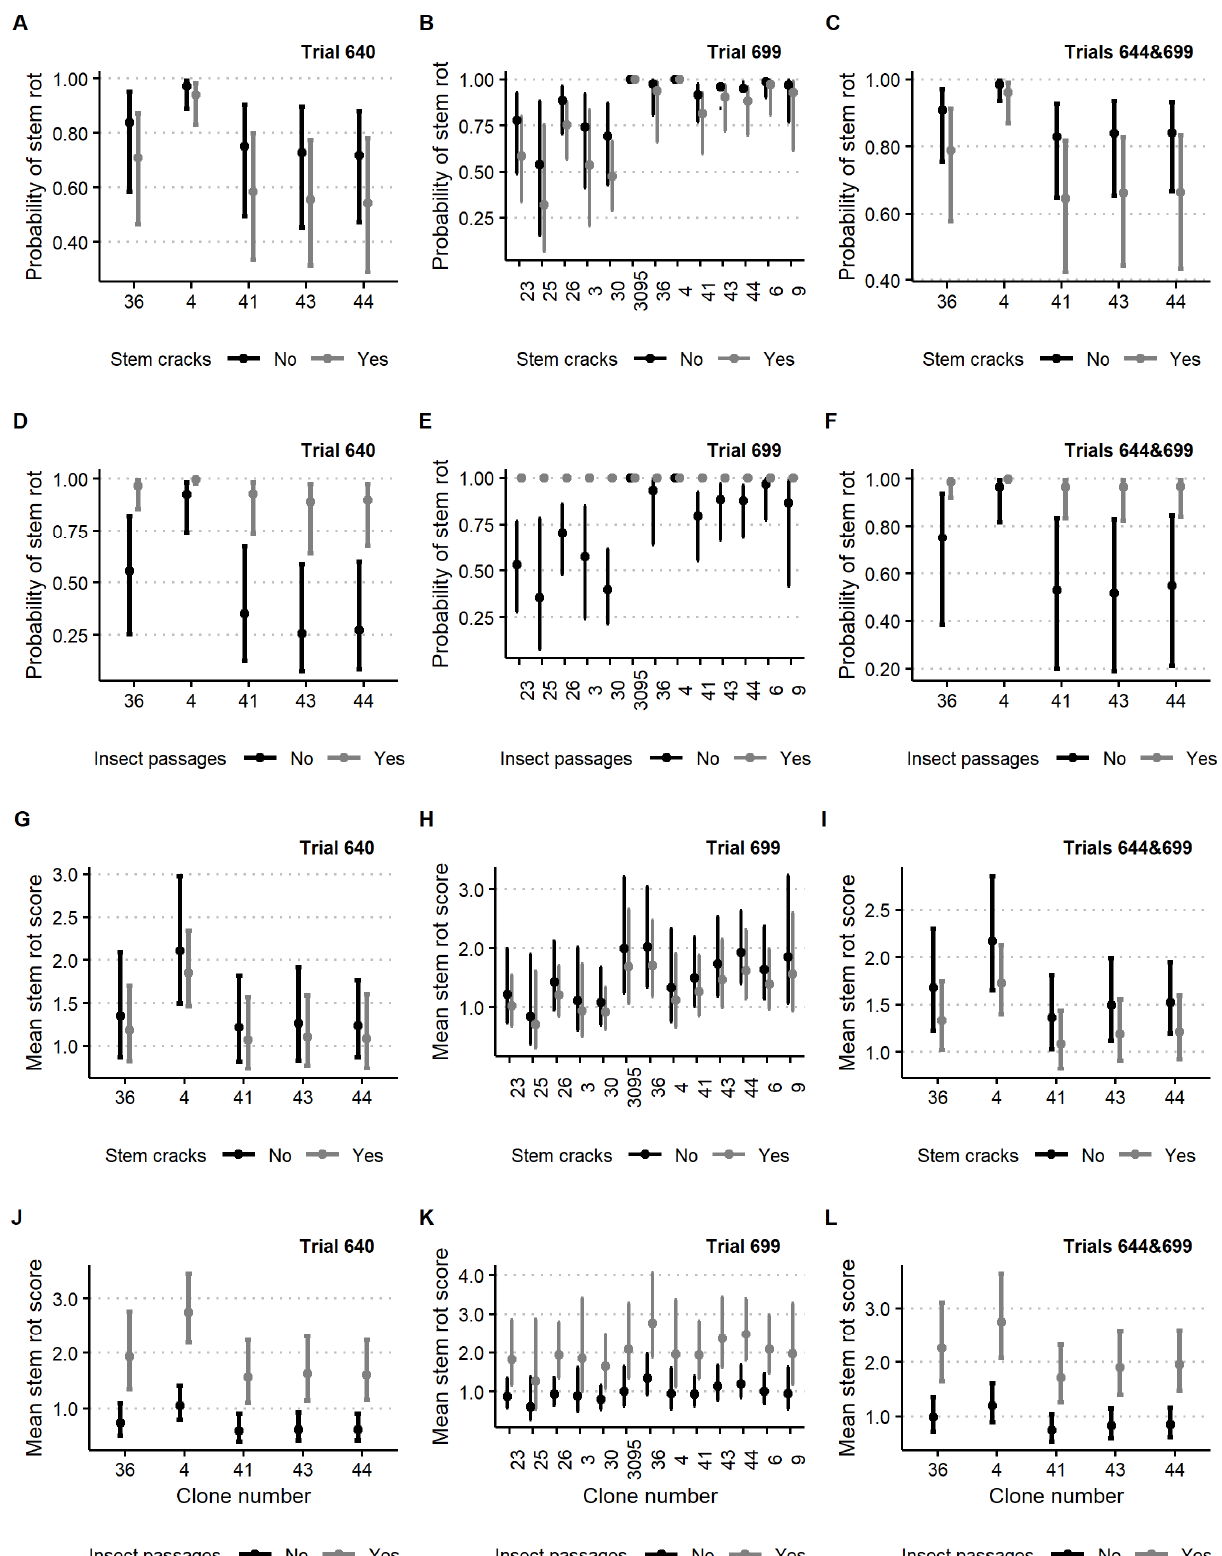
Figure 2. Clone mean probability of stem rot ( A – F ) and mean stem rot grade (score) ( G – L ) grouped by presence/absence of stem cracks and insect passages in the studied trials 640 and 699 and joint-site analyses.